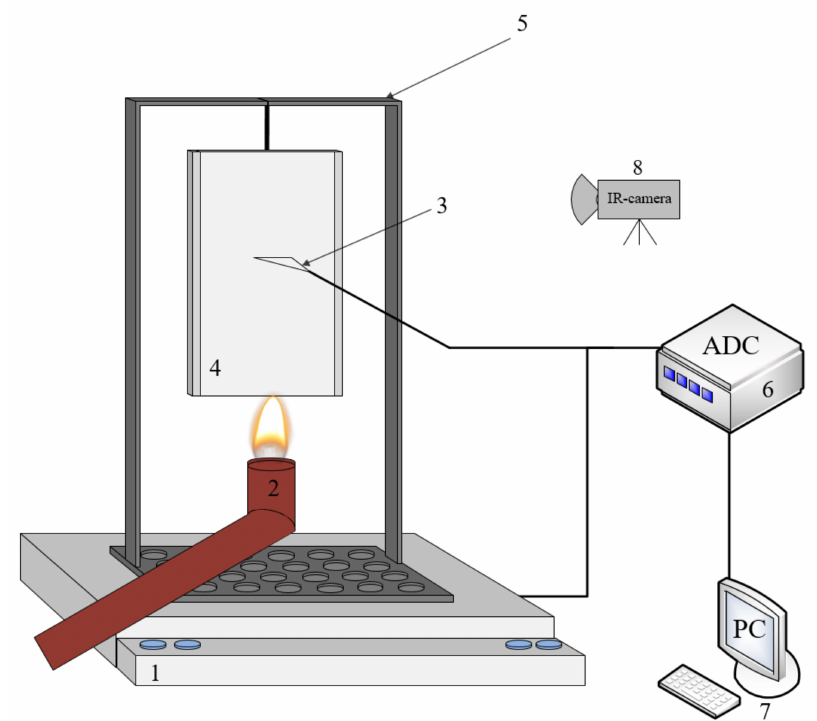
Figure 2. The experimental setup for VBB test. 1—electronic balance, 2—burner, 3—thermocouple for calibration, 4—sample, 5—sample holder, 6—ADC, 7—PC,